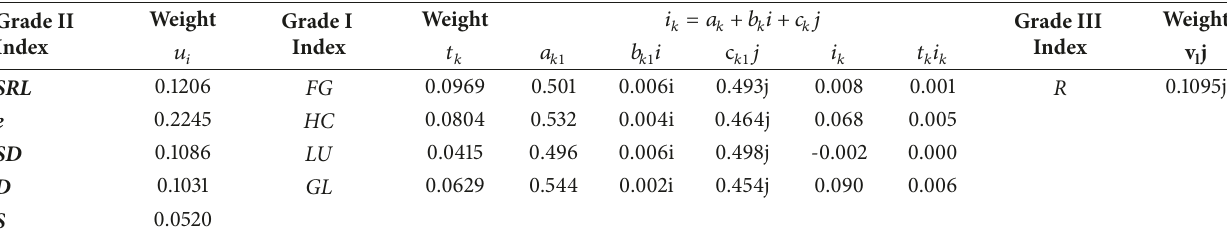
Table 15: Results of connection degree 𝜇(𝐴,𝐵 2 ) A .